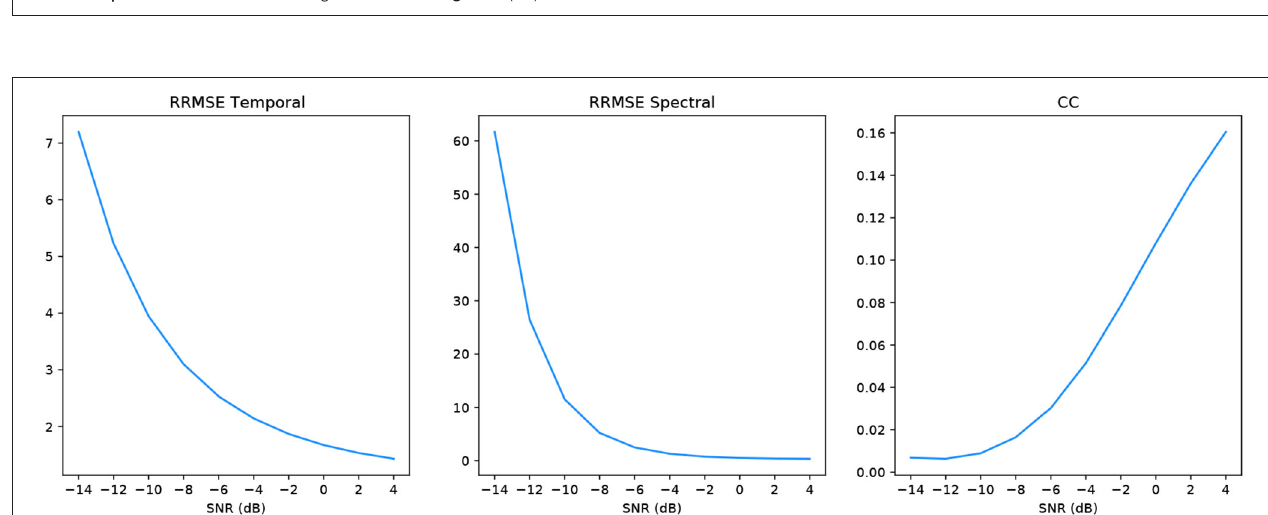
FIGURE 6 | Metrics of the EEG-EOG signals shown in Figure 5 (left).